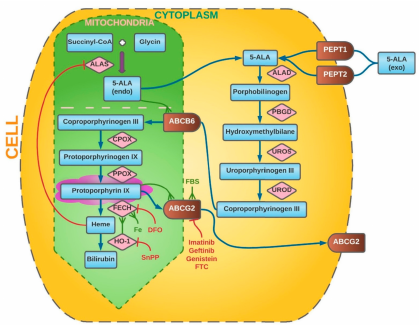
Figure 1. Intracellular metabolism of 5-ALA. The synthesis steps of heme metabolism are labelled by blue arrows ( ↑ ). Red indicators (T) point to enzymes and substances that inhibit particular steps of metabolism, whereas green indicators ( Ψ ) highlight factors that promote them. PEPT